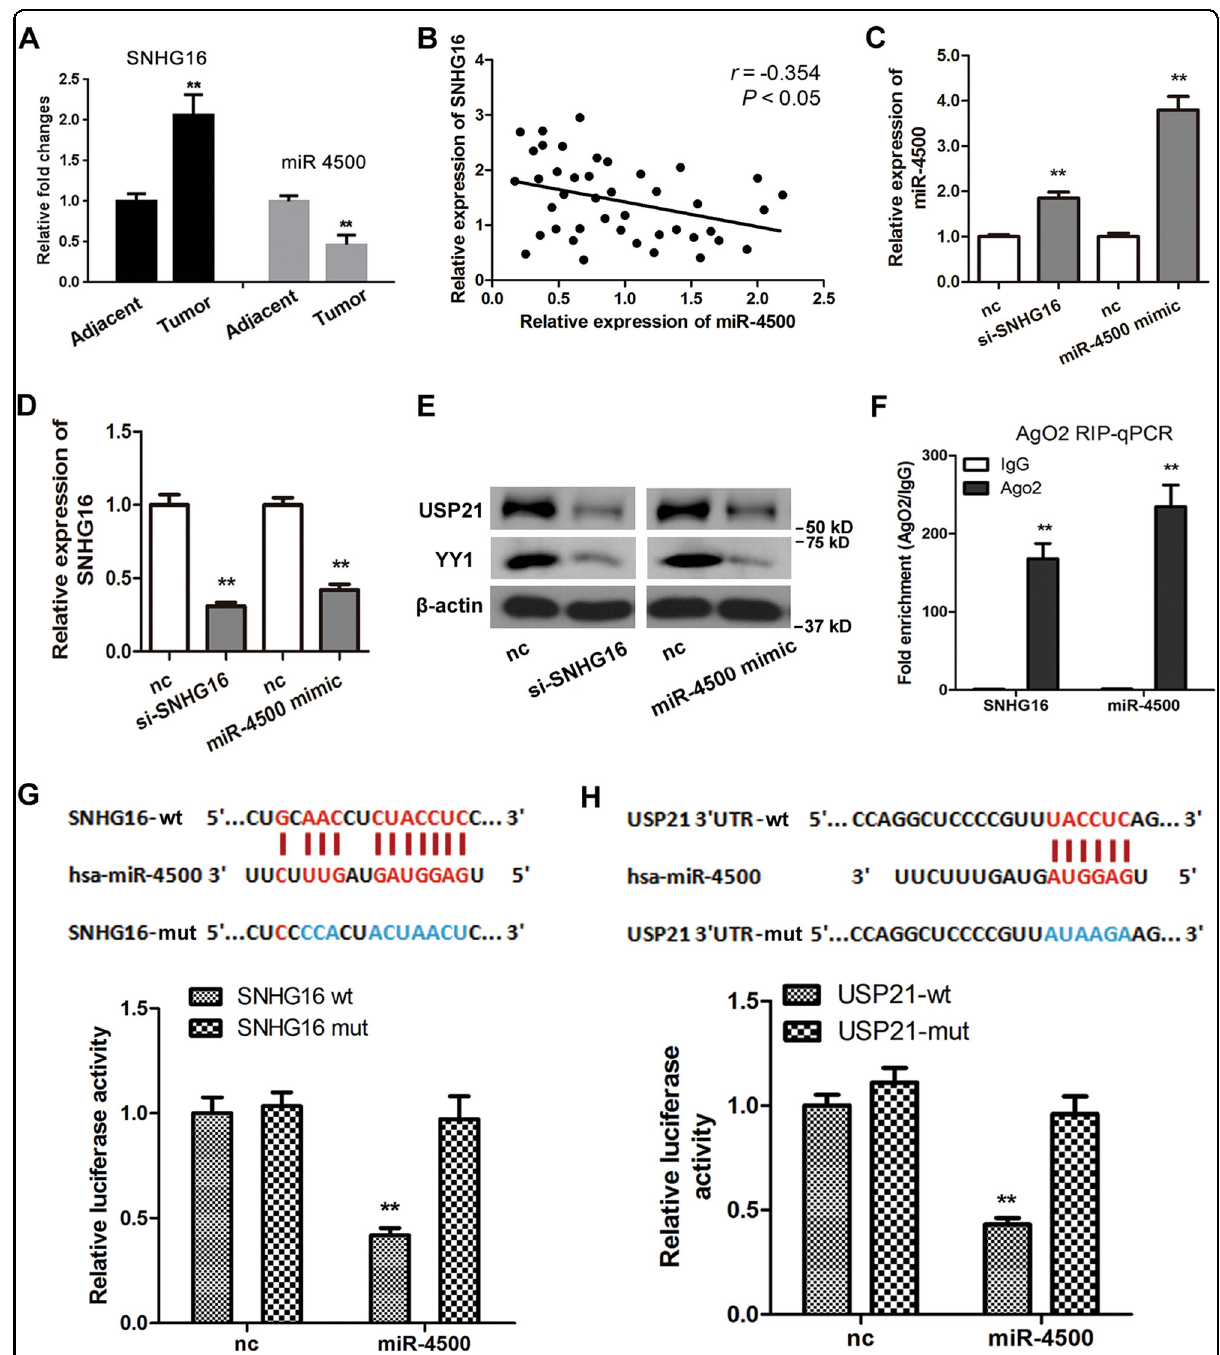
Fig. 7 SNHG16 regulates USP21 expression by targeting miR-4500. a Relative expression of lncRNA SNHG16 and miR-4500 in tumor and adjacent control tissues. b Linear regression correlation analyses of lncRNA SNHG16 and miR-4500 expression. c , d Relative expression of miR-4500 and SNHG16 in A549 cells transfected with si-SNHG16 or miR-4500 mimic. e Western blot analyses of USP21 and YY1 when SNHG16 was silenced or miR-4500 mimics were used. β -Actin was used as an internal control. f RNA-binding protein immunoprecipitation assays with Ago2 antibodies and fold enrichment analyses of SNHG16 and miR-4500. g , h Wild-type and mutated SNHG16 (SNHG16-wt and SNHG16-mut containing the designed mutant sequence in the predicted binding sites of miR-4500) or USP21 3 ′ -UTR (USP21 3 ′ -UTR-wt and USP21 3 ′ -UTR-mut containing the designed mutant sequence in the predicted binding sites of miR-4500) luciferase reporter gene vectors were constructed. The indicated vectors were cotransfected into A549 cells with miR-4500 mimics, and the luciferase activity was then determined using dual luciferase assays. Error bars: mean ± SD. n = 3. ** p < 0.01 vs. the corresponding